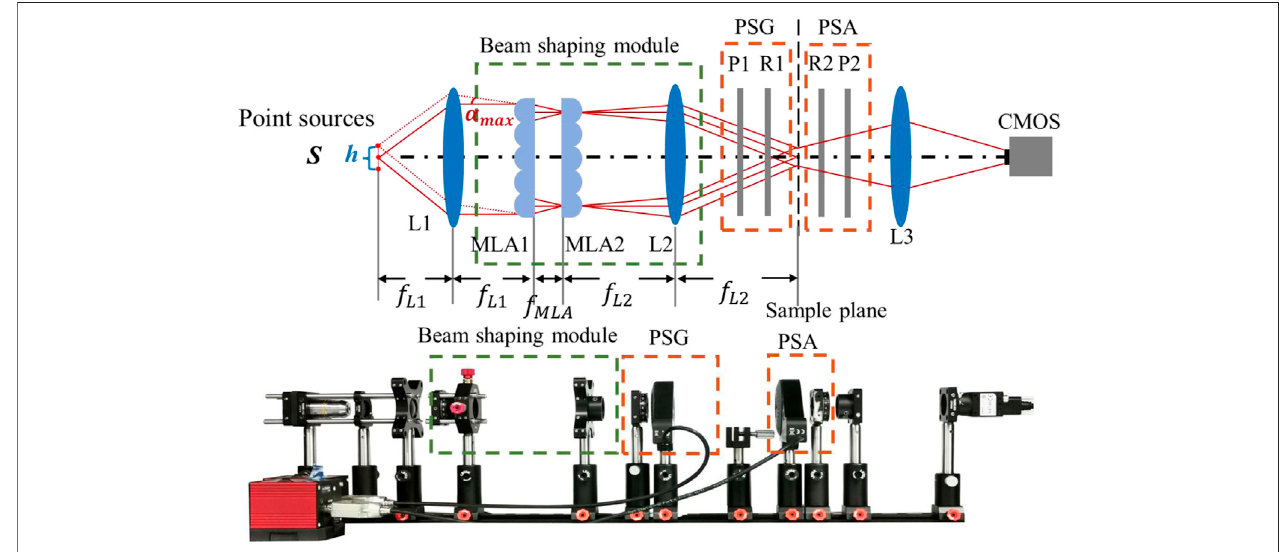
FIGURE 1 | Principle and schematic of the fl at- fi eld Mueller matrix imaging system, which contains point sources, beam shaping module, polarization state generator (PSG), polarization state analyzer (PSA), and CMOS. S, point sources; L, lens; P, polarizer; R, quarter-wave plate; MLA, microlens array.